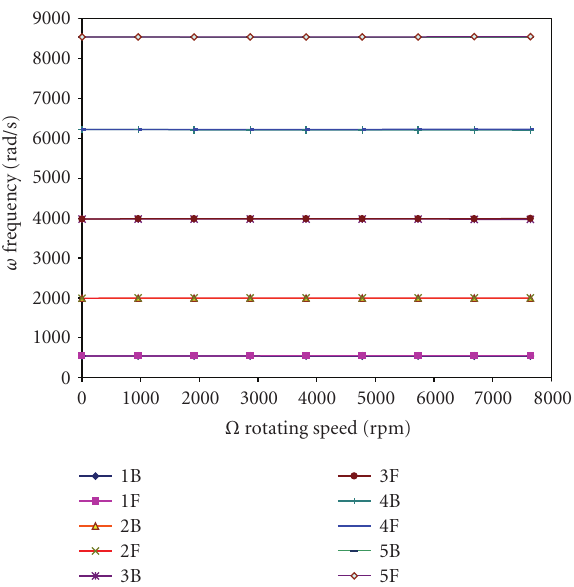
Figure 9: The Campbell diagram of a composite shaft ((F) forward modes, (B) backward modes).